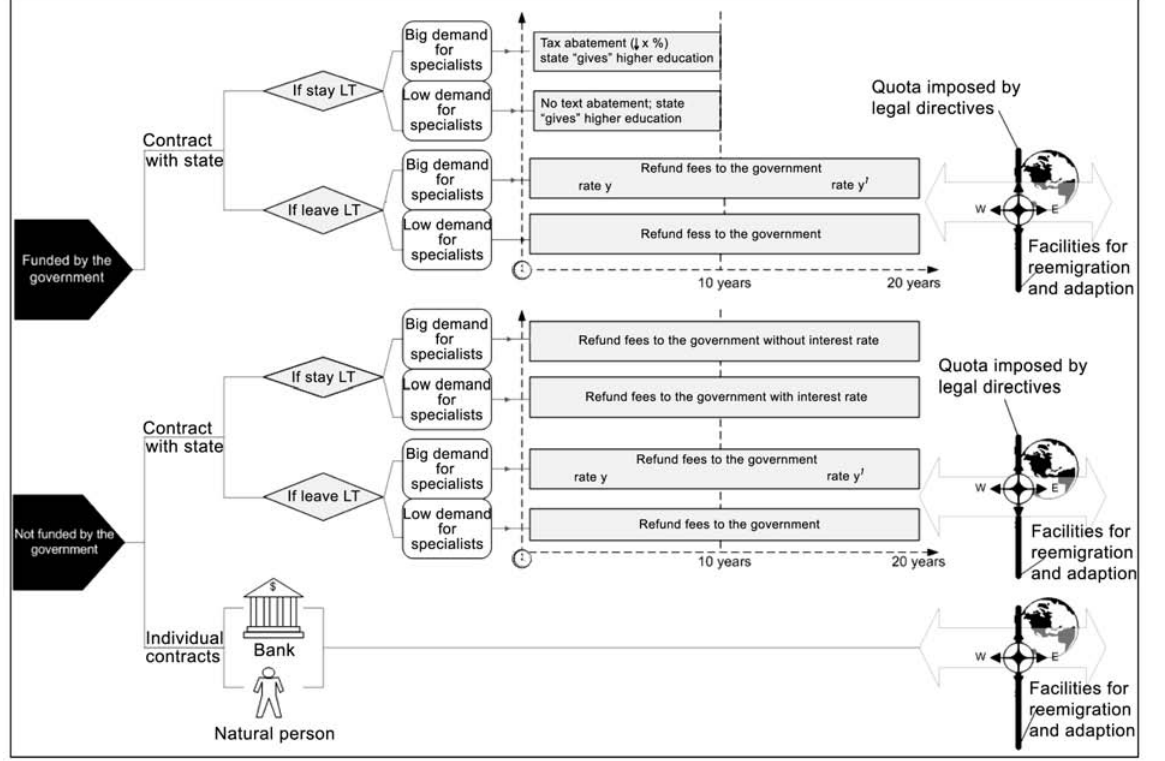
(P), as this system evaluates the deviation of real results (RM) from the expected ones (N = L – RM). The real